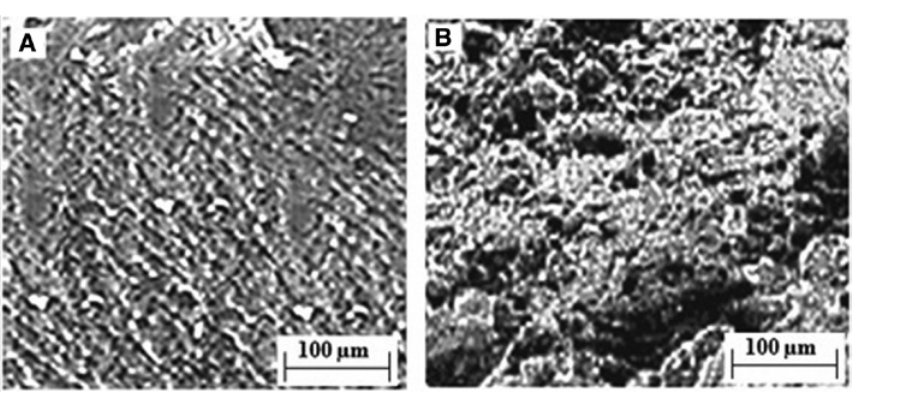
Figure 16: SEM photographs of: (A) AA2014 matrix alloy, (B) AA2014/6.5% carbonized eggshell/11% SiC hybrid composite composites.